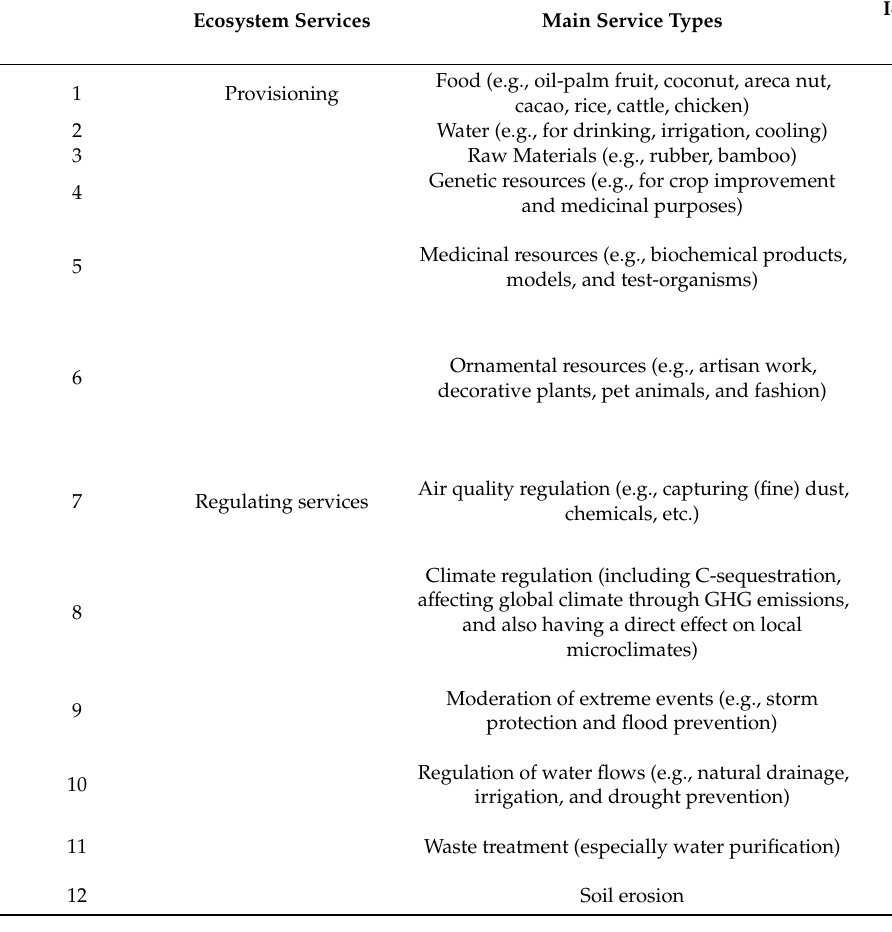
Not Identified in Interviews, but Y Is Identified and Valued in this Identified in the Literature. The Description Study (Indicated by X)